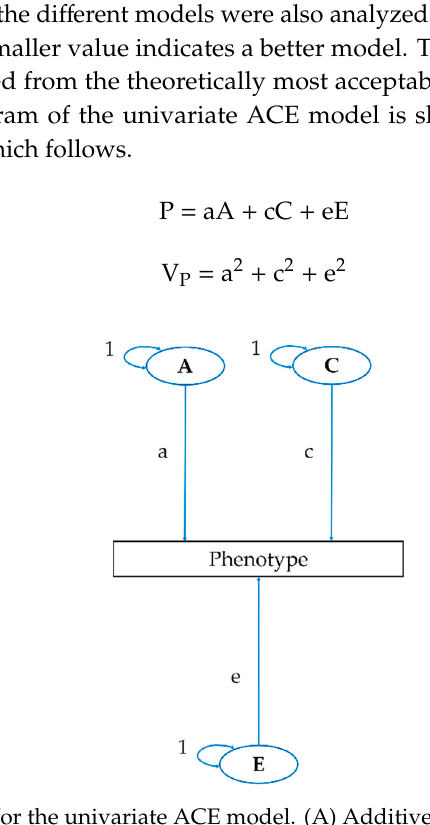
Figure 1. Path diagram for the univariate ACE model. ( A ) Additive genetic factor; ( a ) the path from a genetic factor; ( C ) shared environmental factor; ( c ) the path from a shared environmental factor; ( E ) non-shared environmental factor; ( e ) the path from a non-shared environmental factor. P = aA + cC + eE V P = a 2 + c 2 + e 2